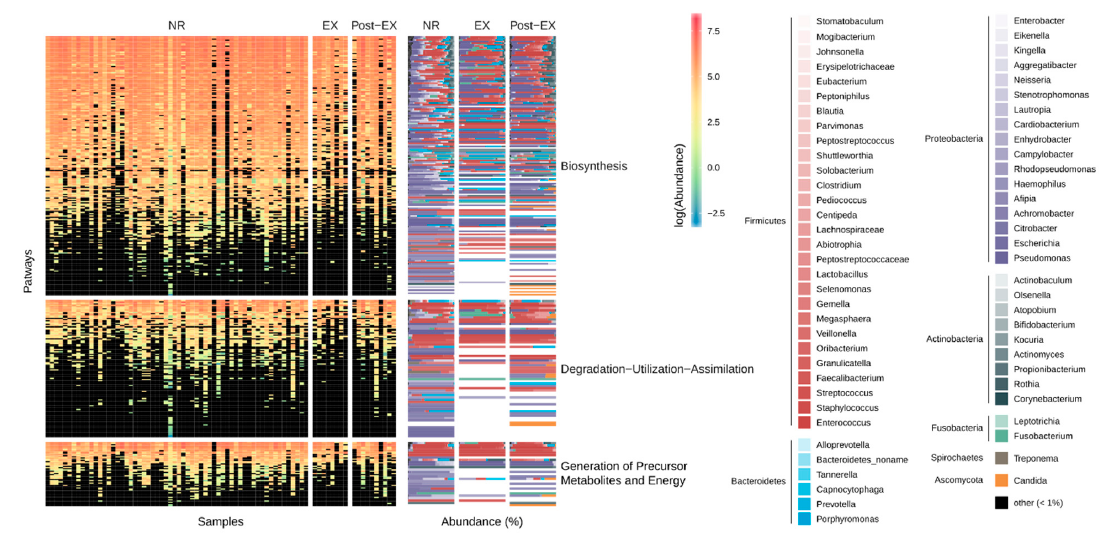
Figure 3. Pathway distribution according to exacerbation events. The pathway distribution was reported for each sample (columns) and for each pathway detected (rows). Colors from dark blue to red were used to report “copies per million” (CPM) values as obtained from HUMAnN2 with black reporting a CPM value of zero. On the right, the percentage of taxa in which each pathway was detected was reported using different colors. The main colors correspond to the Phylum whereas the different shades correspond to the genus detected (if available). BL, baseline; TR, treatment; RC, recovery.